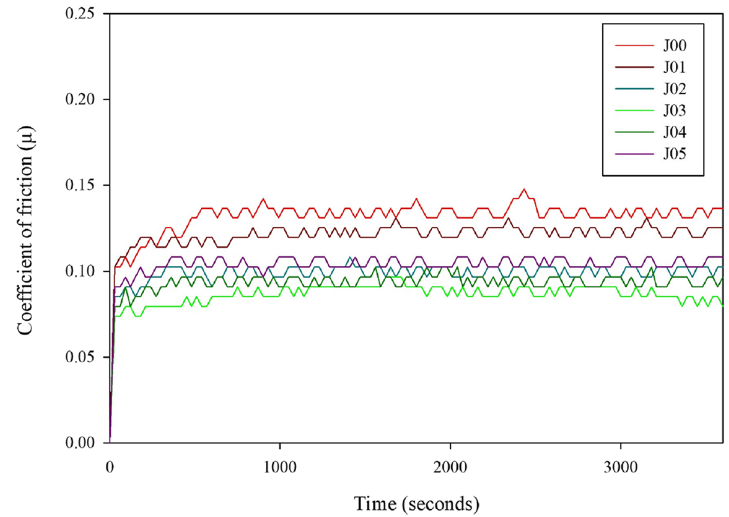
Fig. 7 Coefficient of friction vs. time for concentrations of CaCO 3 NPs in jojoba